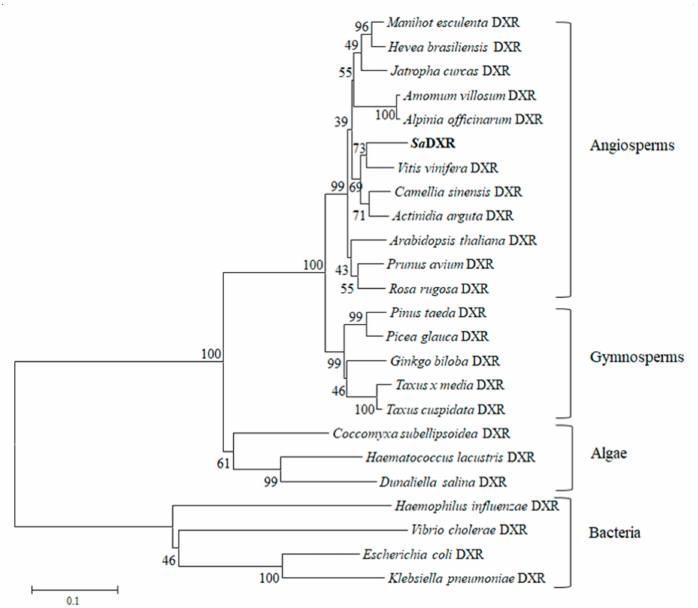
Figure 3. Phylogenetic analysis of the amino acid sequences of DXRs. The neighbor-joining phy- logenetic tree was constructed using the bootstrap method with MEGA 5.1 (1000 bootstrap repli- cations). The protein sequences used in this tree are: Alpinia officinarum (AEK69520.1),